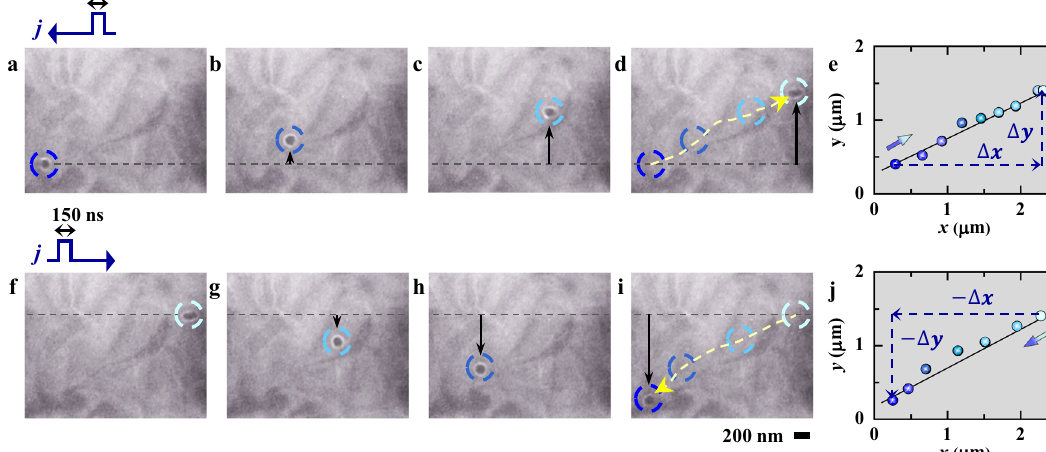
Fig. 2 Motion tracking of the current-driven single-skyrmion at RT. a – d , f – i Over-focus L-TEM images showing the single-skyrmion motion stimulated by a – d negative ( j = − 6.06 × 10 10 A m − 2 ) and f – i positive ( j = 6.32 × 10 10 A m − 2 ) pulsed current with a pulse duration of 150 ns at − 80 mT and RT. The current fl ows from right to left for ( a – d ) and from left to right for ( f – i ) as marked by the arrows above ( a ) and ( f ), respectively. The dashed circles mark the skyrmion locations with the dashed arrows in ( d ) and ( i ) showing the directions of skyrmion trajectory. e , j Summary of the skyrmion motion along ( x -axis) and vertical to ( y -axis) the electric current direction: e skyrmion positions at j = − 6.06 × 10 10 A m − 2 obtained from ( a – d ) and Supplementary Movie 1, and ( j ) those at j = 6.32 × 10 10 A m − 2 obtained from ( f – i ) and Supplementary Movie 2. The straight lines in ( e ) and ( j ) are for the Hall angle estimations, i.e., 4 y 4 x for ( e ) and (cid:3)4 y (cid:3)4 x for ( j ).